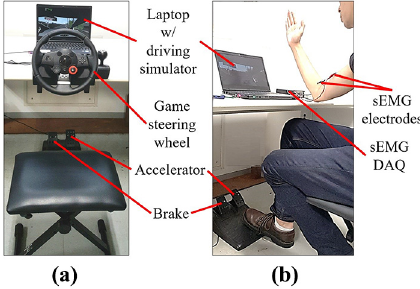
Figure 7 Experimental